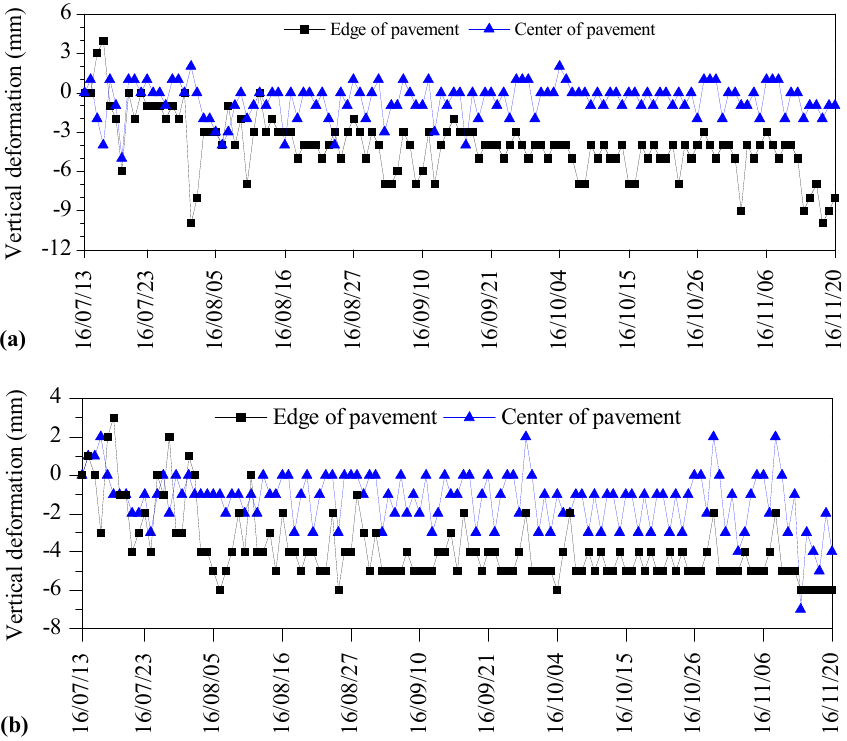
Figure 12. Vertical displacement of the BCS foundation during the period July 2016–November 2016. Replacement of BCS with ( a ) soil stabilized with lime and natural pozzolans and ( b ) gravel soil.